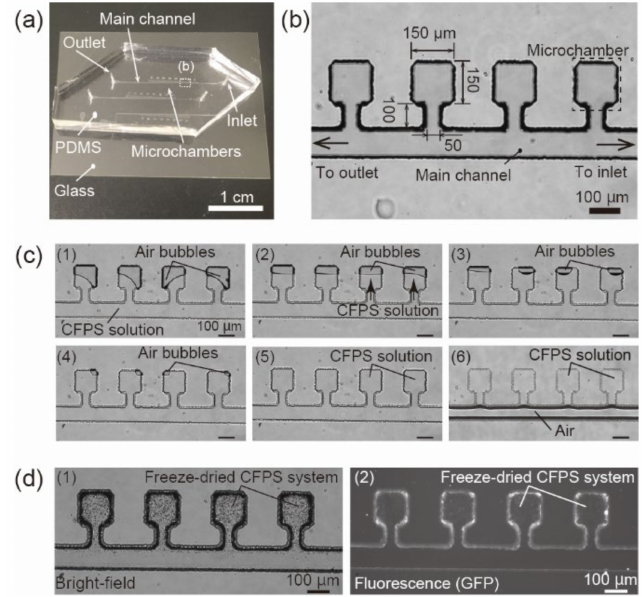
Figure 1. Fabrication procedures of the microfluidic device integrated with the cell-free protein synthesis (CFPS) system. ( a ) Image of the whole microfluidic device. ( b ) Microscopic image of the microchambers in the microfluidic device. ( c ) Time-lapse microscopic images during the procedures to introduce the CFPS solution in the microchambers. ( d ) Bright-field image (d1) and fluorescent image (d2) of the freeze-dried CFPS system in the microchambers. The freeze-drying condition was ~10 mTorr, − 20 ◦ C, 3